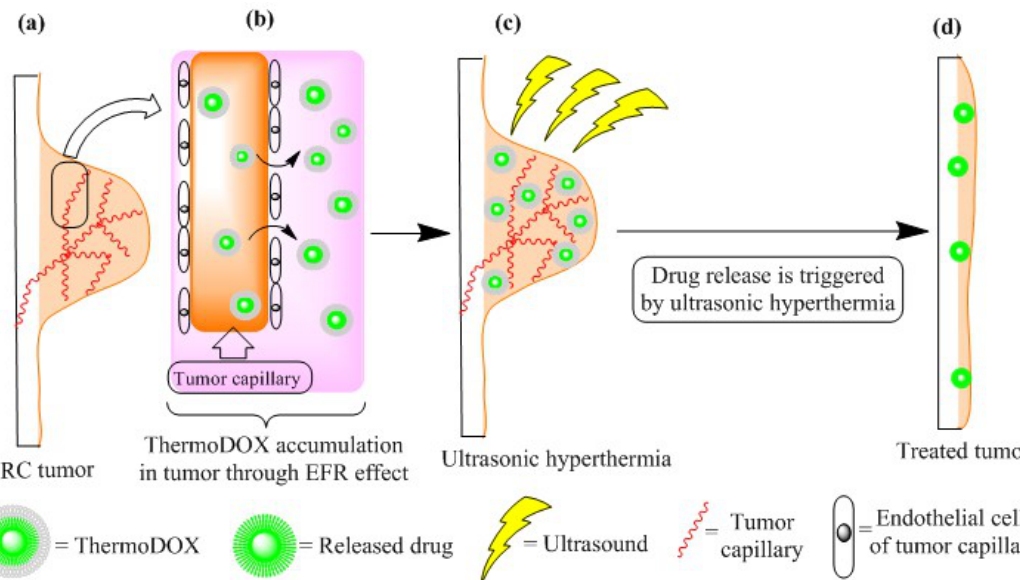
Fig. 3. the schematic diagram of the mechanism of Thermodox in colorectal cancer (CRC), (a) CRC tumor, (b) the enhanced penetration and retention (EPR) effect, (c) local hyperthermia, induced by ultrasound waves, causes drug release from the Thermodox formulation, (d) treated tumor